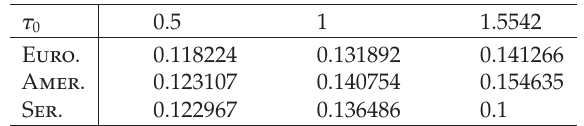
= 1 . 0, E = 1 . 1, r = 0 . 05, D = 0 . 01, σ = 0 . 25. Table 2.7 . Put: Run 1; S 0 0 Euro. and Amer. are values of European and American options com- puted using a 100,000 step binomial tree. Ser is the value of an Amer- ican option computed using a 100,000 path Monte Carlo simulation taking series ( 1.4 ) as the exercise boundary.